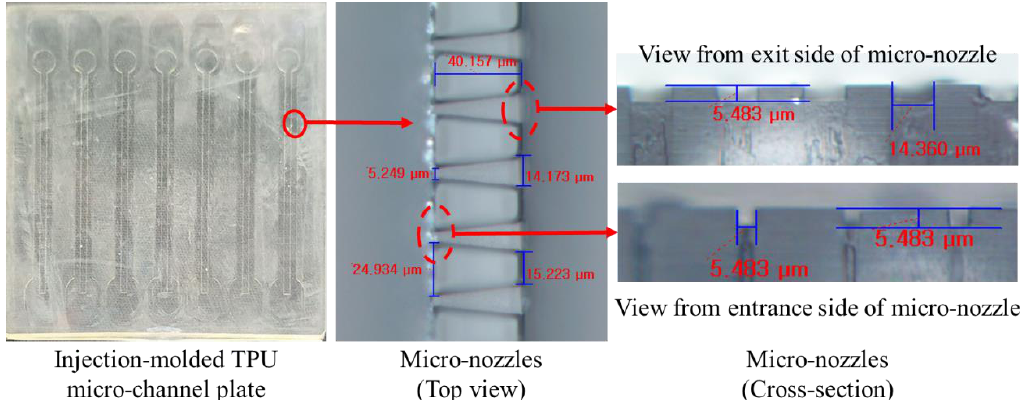
Figure 8. Photo for an injection-molded thermoplastic urethane (TPU) micro-channel plate and microscopic images for micro-nozzles.